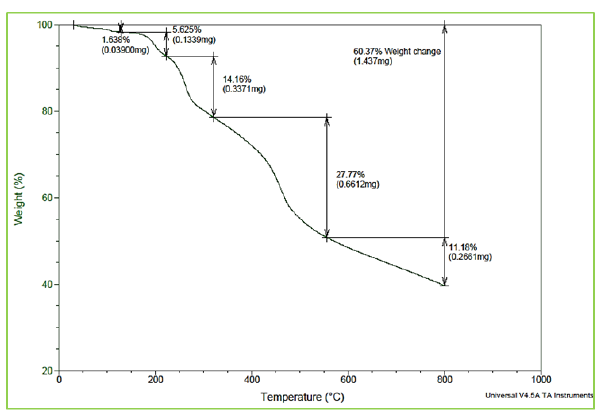
Fig. 5. TGA curve of palladium complexes of 2-Amino 4-(4-Chloro-